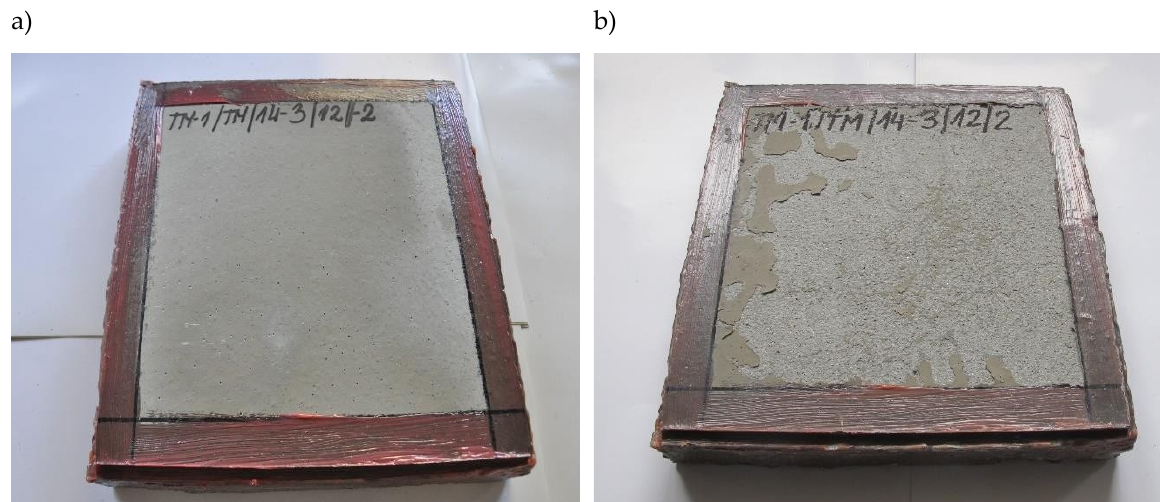
Figure 13. View of mortar sample TM-1/TM/14-3 (object II); ( a ) before the frost resistance test according to [4], and ( b ) after the frost resistance test according to [4].